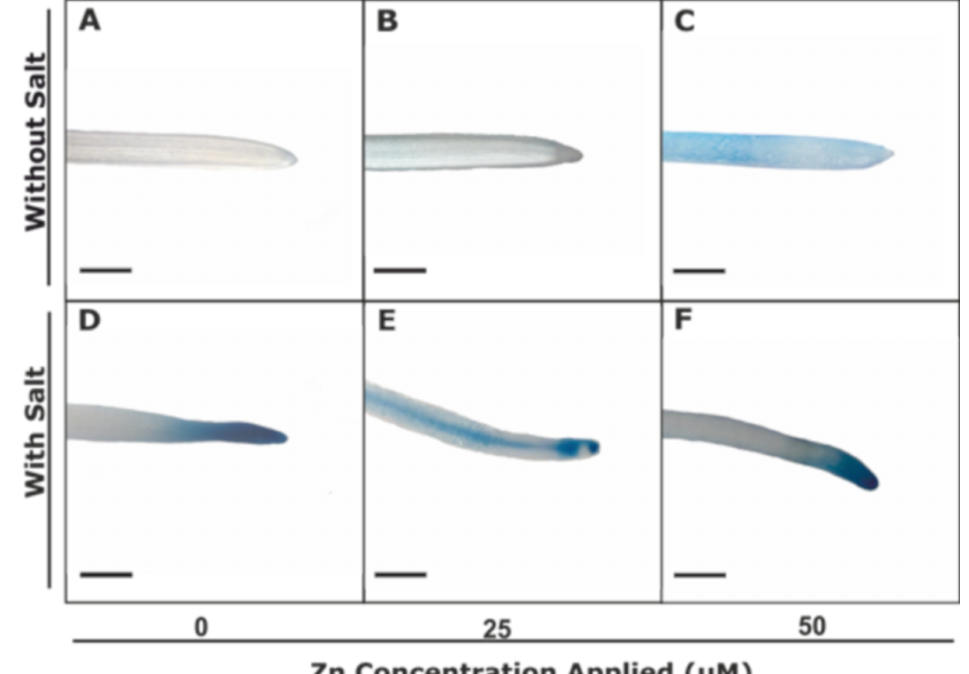
Figure 2. Membrane integrity of pak choi roots under di ff erent treatments of Zn and / or salts staining by Evan´s blue. Blue colours show the loss of integrity areas. ( A ) control roots. ( B , C ) roots under not salinity condition with Zn application. ( D ) roots under salinity condition. ( E , F ) roots under salinity condition with Zn